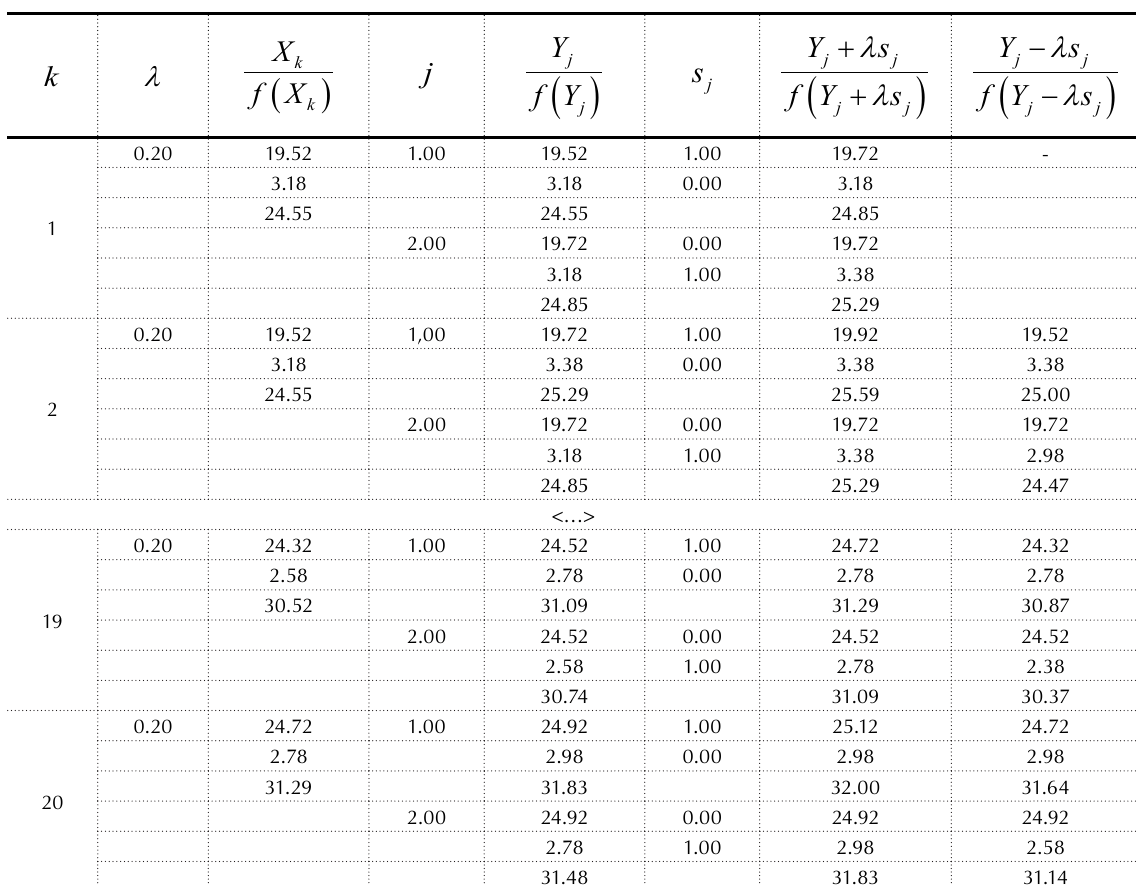
Table 3. Iteration procedure of optimization